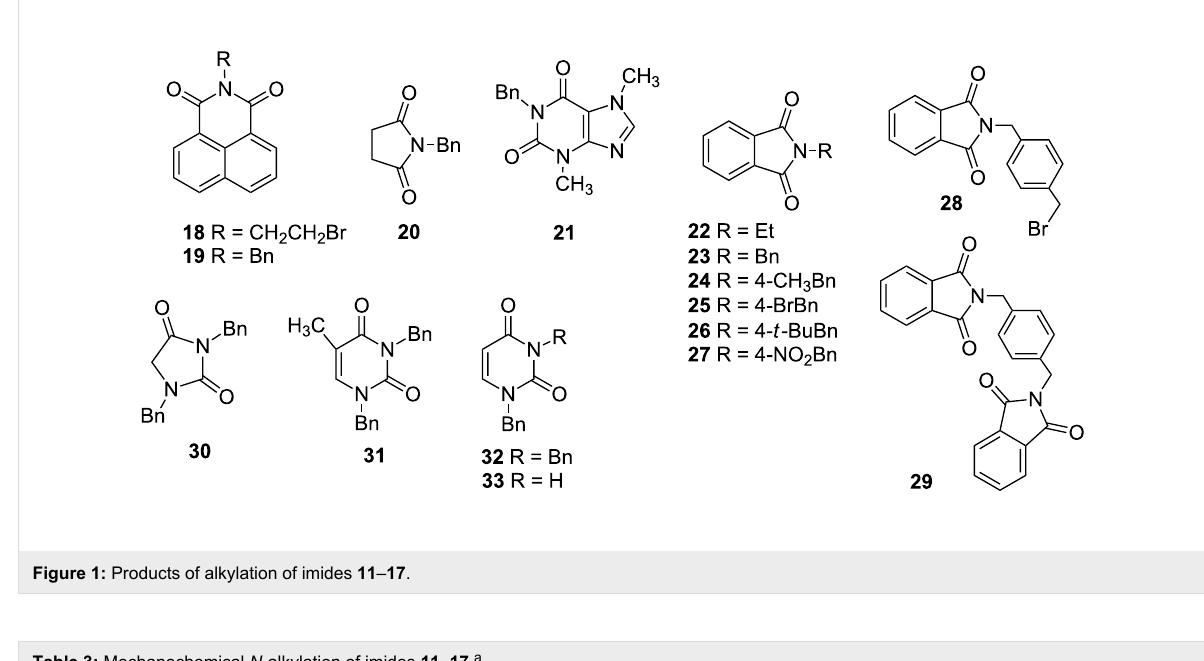
Table 3: Mechanochemical N -alkylation of imides 11–17 . a